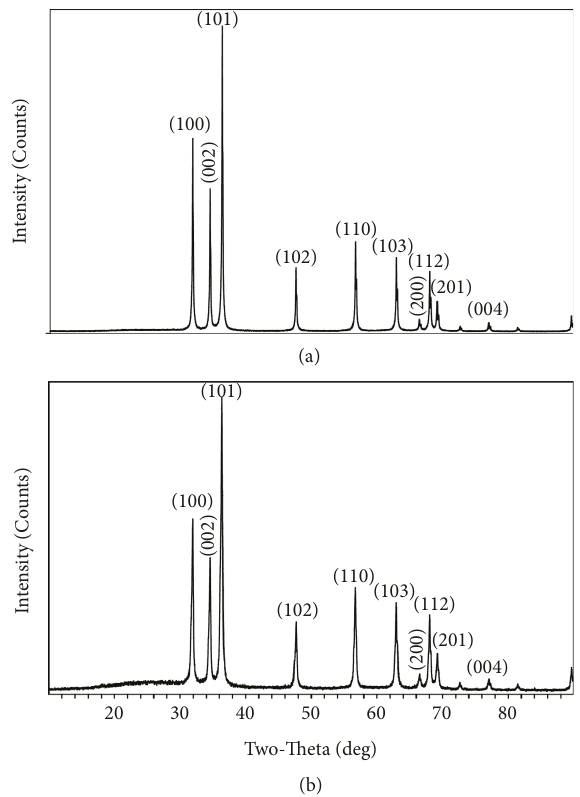
Figure 5: XRD patterns of (a) zinc oxide nanoparticles (ZnONPs) and (b) plant-fabricated zinc oxide nanoparticles (PF-ZnONPs).